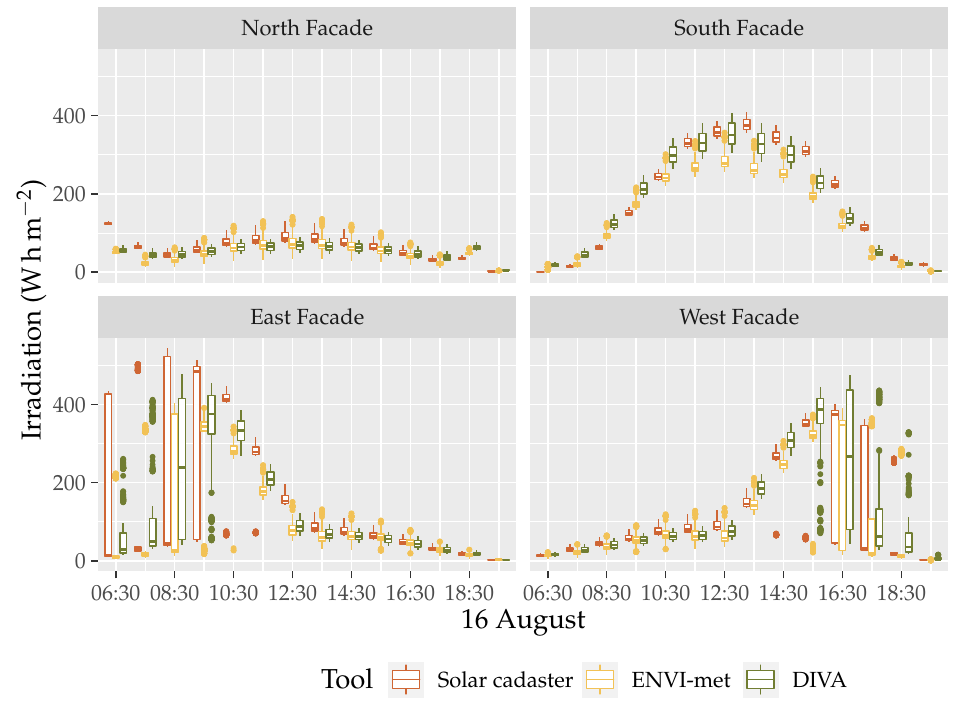
Figure 16. Distribution of the irradiance over the vertical facades for the homogeneous district in August. The level of irradiance on unshaded roofs appears to be perfectly homogeneous and equal for the three tools considered, and it corresponds to the sum of the BHI and the DHI when given as the input of the